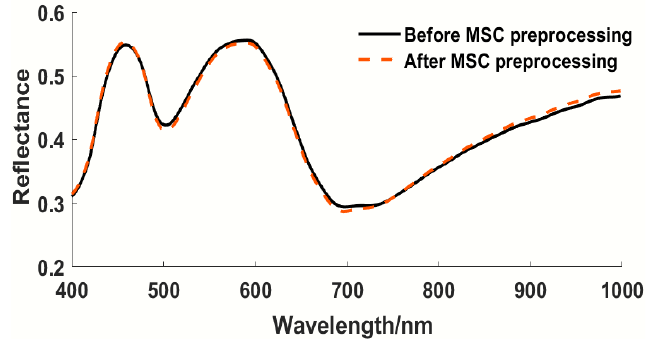
Figure 4. Mean spectra of MSC pretreatment.